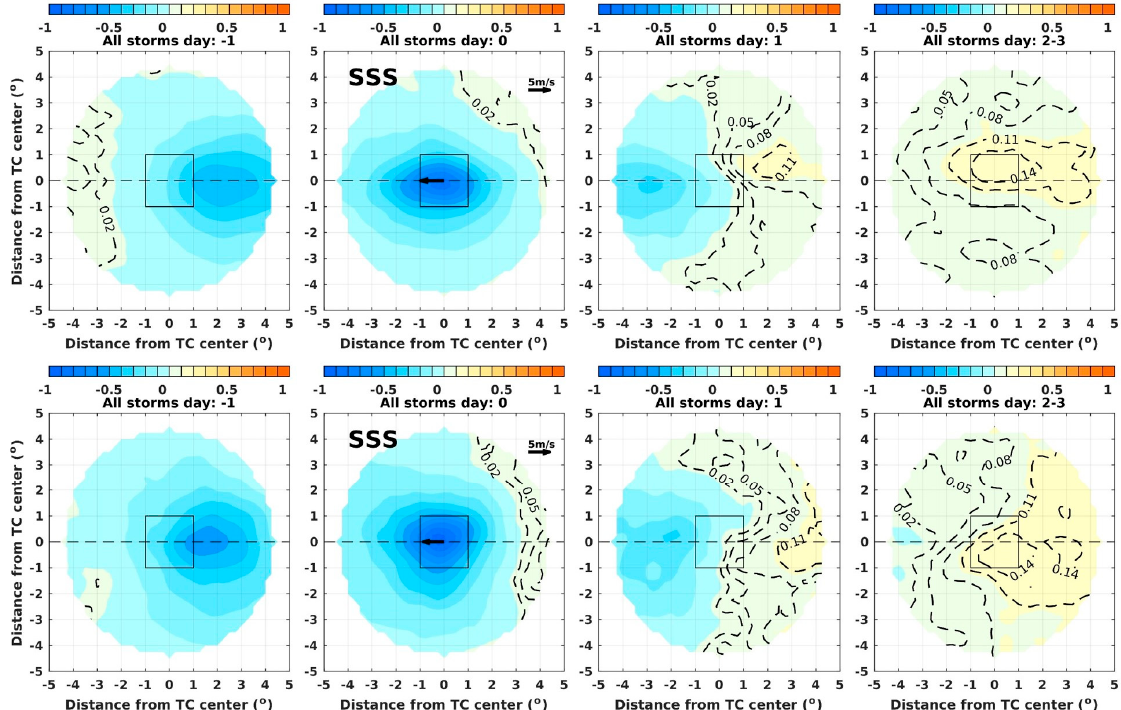
Figure 6. Distribution of the SSS anomaly using SMOS swath daily data (L2) from 2010 to 2019 with surface wind higher than 15 m s − 1 associated SSS removed in the Northern (upper panels) and Southern (lower panels) Hemisphere.